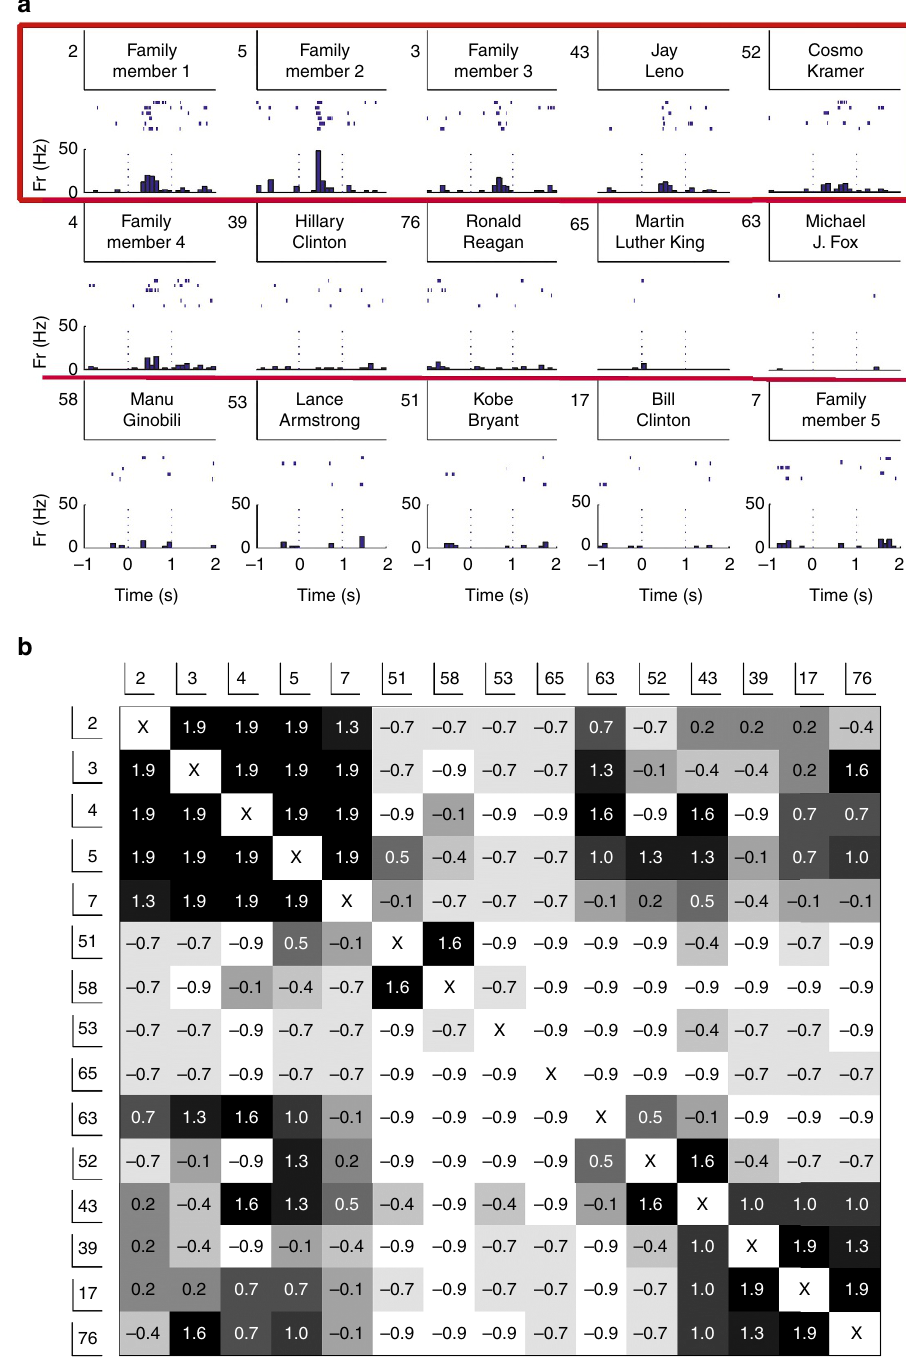
Figure 1 | Exemplary neuron encoding long-term associations. ( a ) A single neuron in the hippocampus that fired to pictures of the patient’s relatives (pictures covered for confidentiality reasons) and to two celebrities that were related, according to the patient’s report, to one of the relatives (stimulus 5). The red frame marks significant responses. Time zero marks the onset of picture presentations, shown for 1s. ( b ) Personal association matrix filled by the patient with a z -score normalization. The association scores for the pictures to which the neuron fired (mean: 0.889) were higher than the scores obtained for other pictures (mean: 0.122). Owing to copyright issues, the images depicting people are replaced by their names. For the original figures see https://